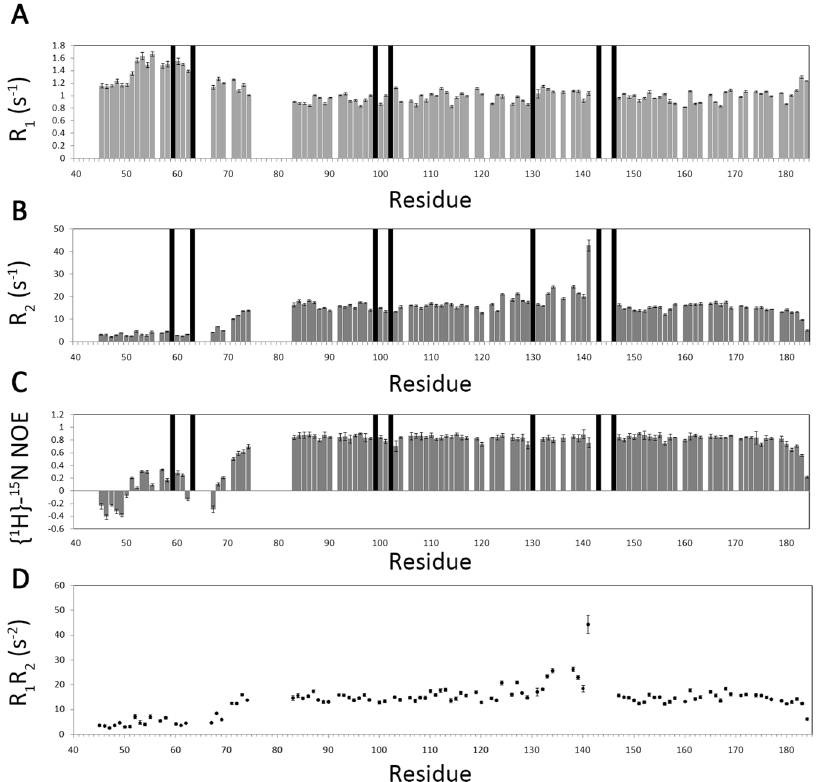
Figure 2. Backbone dynamics of FL 1CGrx1 probed by 15 N-relaxation rates measured at a proton Larmor frequency of 600 MHz, at 298 K. Residues with severe peak overlap or poor signal-to-noise ration were excluded; proline residues are indicated with black bars. Longitudinal relaxation rate R 1 ( A ), transverse relaxation rates R 2 ( B ), steady-state 1 H- 15 N heteronuclear NOE ( C ) and the product R 1 R 2 ( D ) are shown as a function of the protein